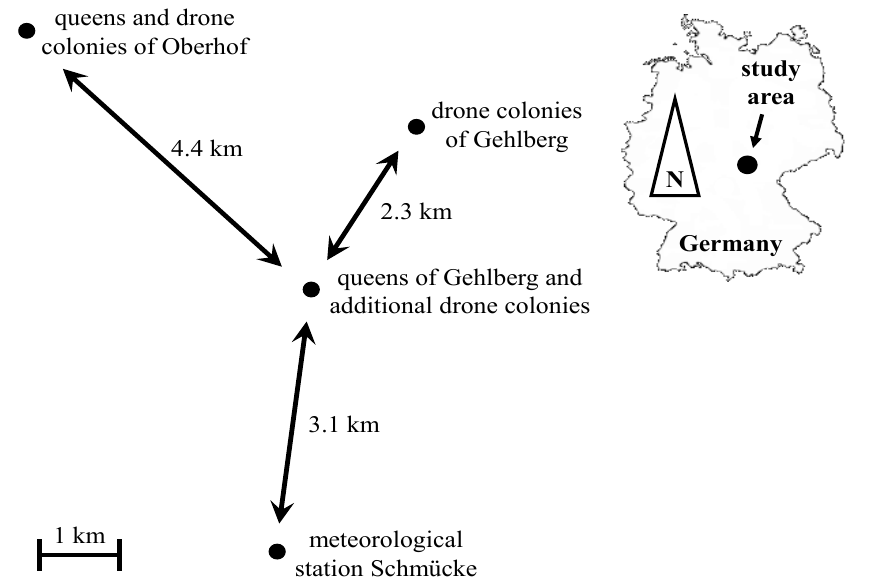
Figure 1. Location of the mating apiaries Gehlberg and Oberhof in the rural district ‘Ilm-Kreis’ in Middle-Thuringia,